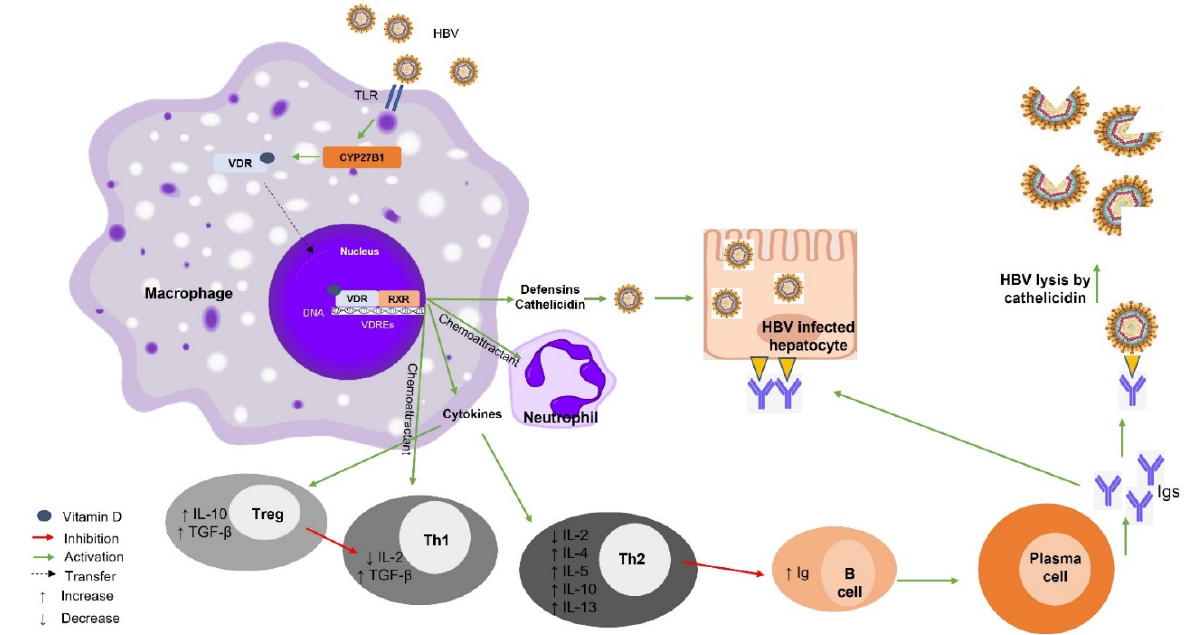
Figure 1. Vitamin D–VDR-mediated effects on hepatitis B infection. Binding of HBV to TLR leads to increased vitamin D production and CYP27B1 stimulation. Binding of VDR to RXR and their recruitment to VDREs leads to the secretion of defensins, cathelicidins, and cytokines. The expression of these immunomodulators leads to the transition from a pro-inflammatory response mediated mainly by Th1 cells and antibody production to an anti-inflammatory response mediated mainly by Tregs and Th2 cells. HBV, hepatitis B virus; TLR, Toll-like receptor; VDR, vitamin D receptor; RXR, retinoid X receptor; VDRE, vitamin D response element; Th1, T helper 1; Th2, T helper 2; CYP27B1, cytochrome P450, family 27, subfamily B, polypeptide 1; Tregs, T regulatory cells; Ig, immunoglobulin; IL-, interleukin; TGF- β , transforming growth factor beta.